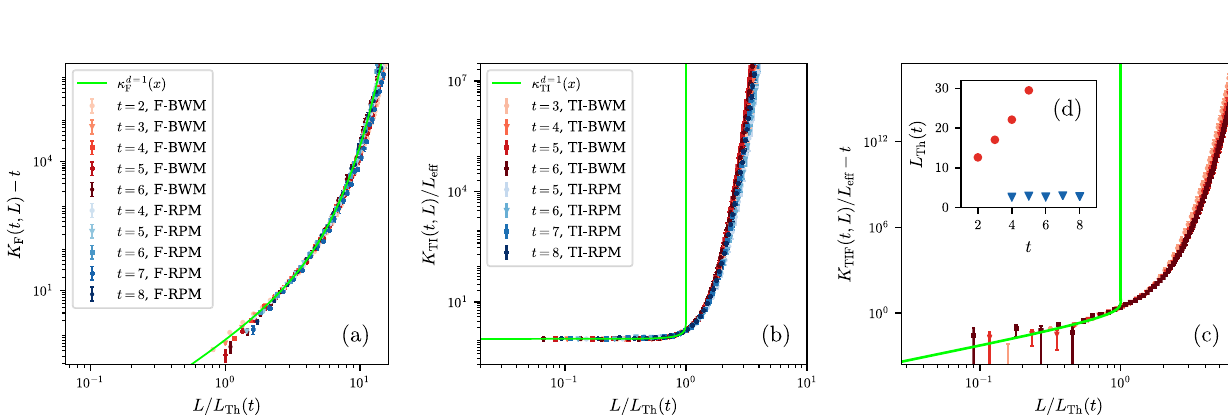
q scalingformsareplottedingreen. c shows t =2,3,4fromlighttodarkred. d L Th is plottedagainst t forTIFBWM(red)andTIFRPM(blue).TheTIFRPMisnotshownin c because the apparent L Th ( t ) is too small (as seen in the inset) to be reliably estimated (see Supplementary Information (SI) for